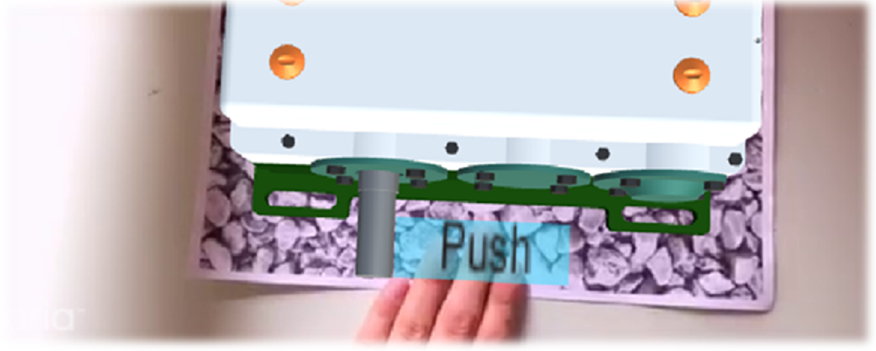
Figure 17. Virtual Button in AR.